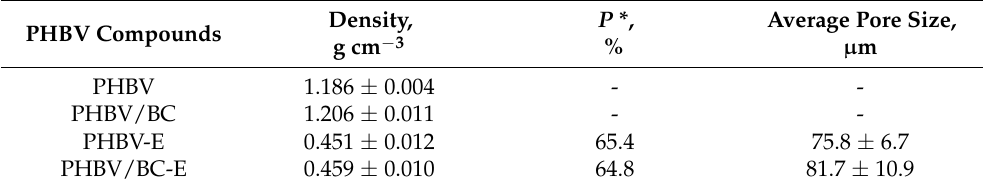
Table 1. Density, porosity ( P ), and average pore size of PHBV-E and PHBV/BC-E. PHBV Compounds PHBV